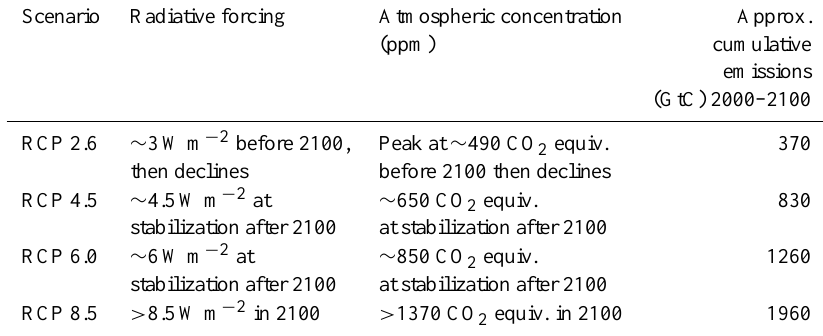
Table 2. RCP scenarios (from Moss et al . ,